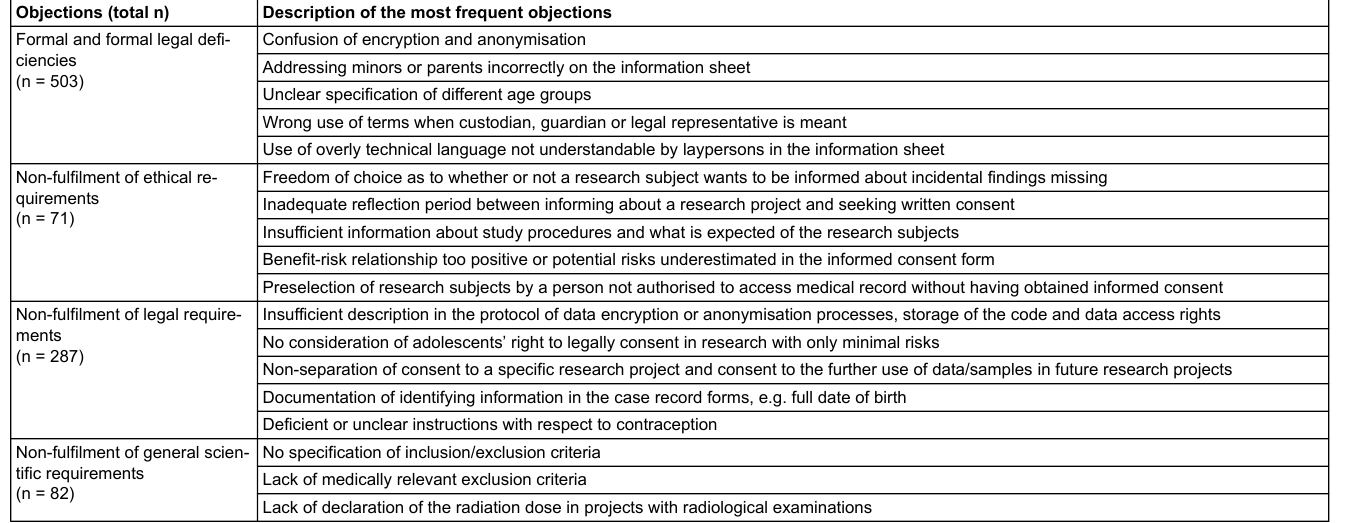
Table 1: Objections regarding formal and formal legal deficiencies and ethical, legal or scientific requirements in the 74 submissions analysed. Objections (total